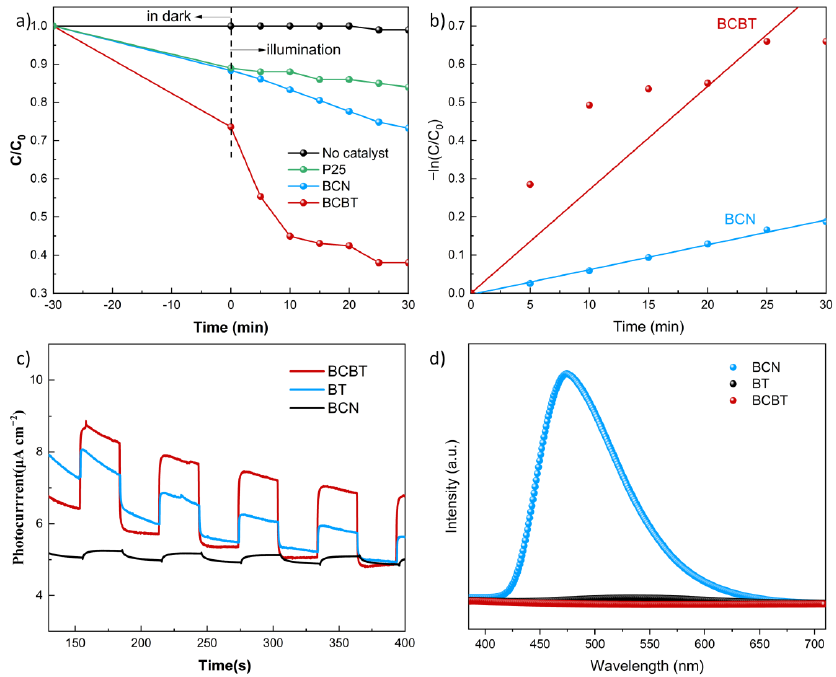
Figure 5. Photocatalytic degradation efficiencies on the degradation of TC under simulated solar light irradiation ( a ), and kinetic linear simulation curves ( b ), photocurrent curves ( c ), and PL spectra ( d ) of BT, BCN, and BCBT, respectively.